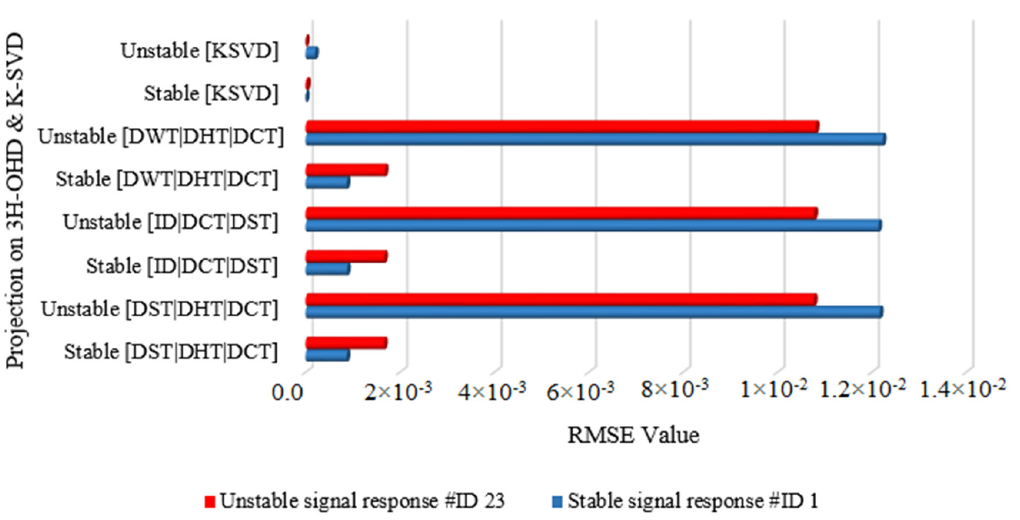
Figure 9. Projections of signals ID 1 and ID 23 on stable and unstable 3H-OHD and ADL.